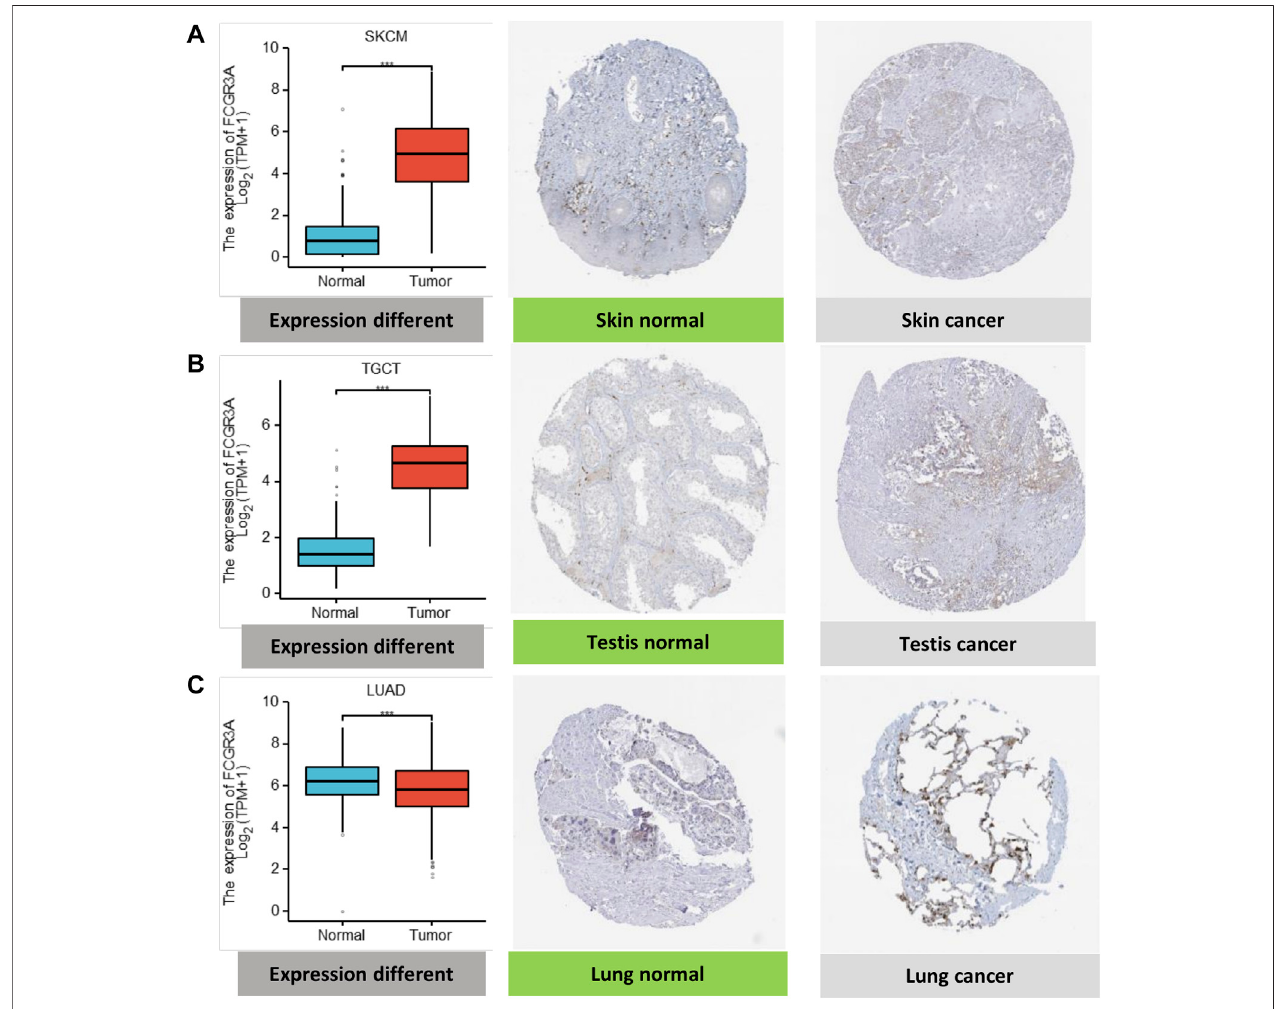
FIGURE 2 | Comparison of FCGR3A gene expression between normal and tumor tissues (left) and immunohistochemistry images in normal (middle) and tumor (right) tissues. (A) Skin; (B) Testis; (C) Lung. * p < 0.05; ** p < 0.01; *** p < 0.001.